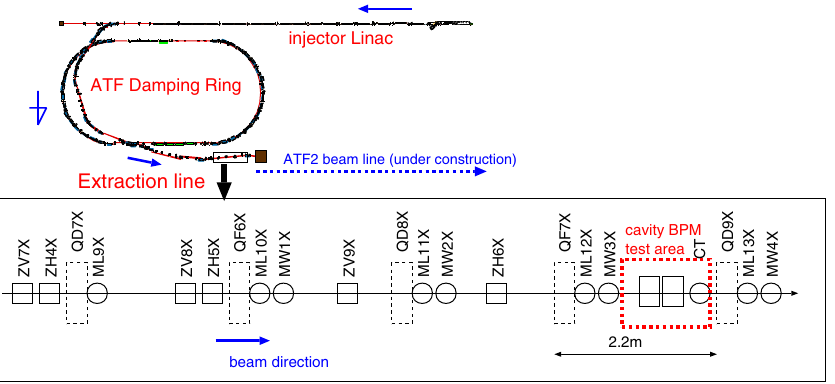
FIG. 7. (Color) Beam line layout near the cavity BPM system. QDnX and QFnX are quadrupole magnets. MLnX are stripline BPMs attached on quadrupole magnets. ZVnX and ZHnX are steering magnets for the vertical and the horizontal direction, respectively. MWnX are wire scanners.